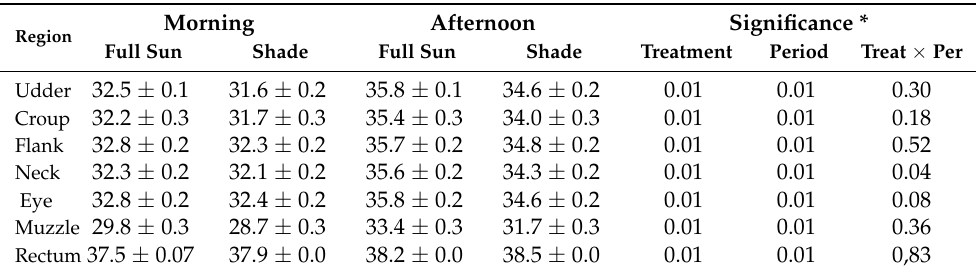
Table 6. Average surface temperature by thermography and rectal temperature in Gyr and Girolando cows in full sun and shade ICLF in the morning and afternoon in different body sites.